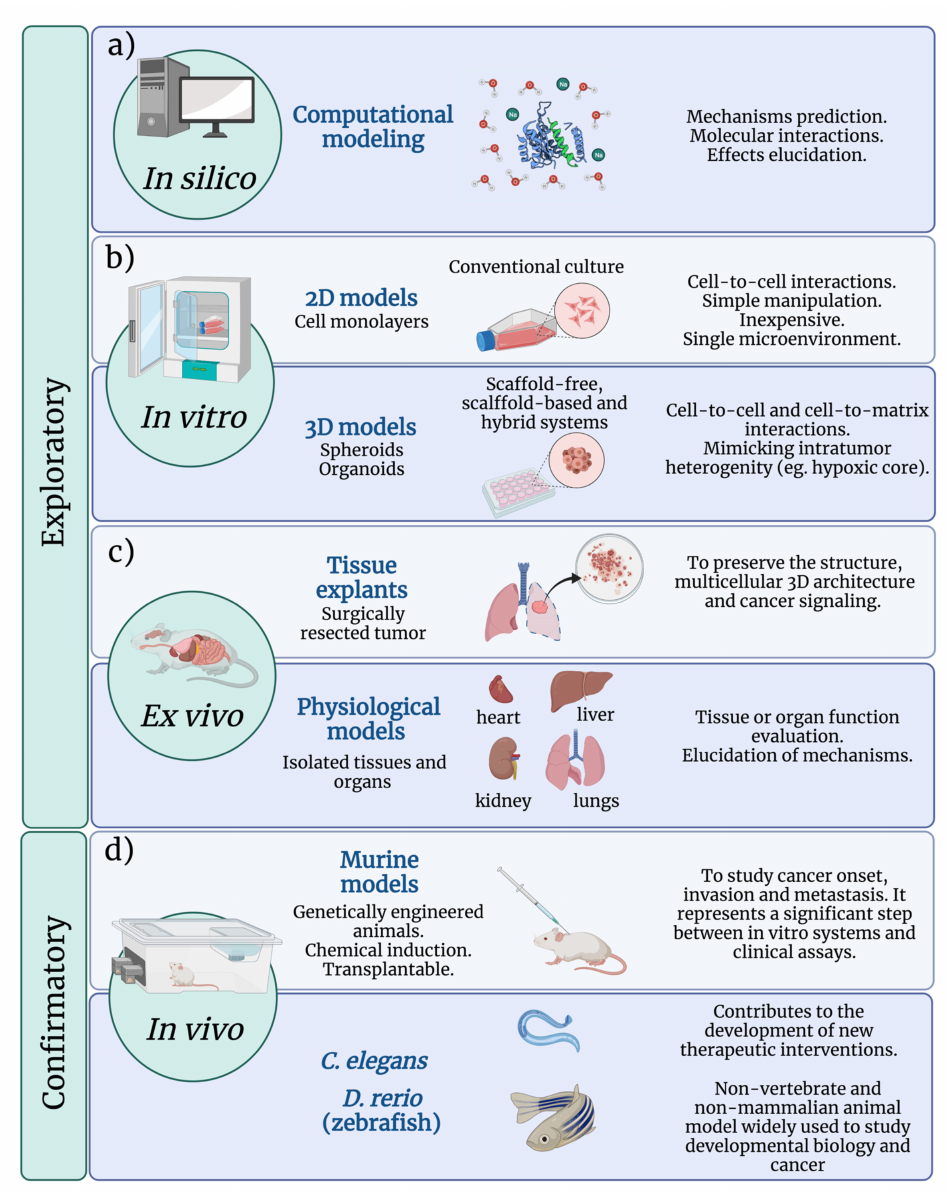
Figure 4. Features of ( a ) in silico ( b ) in vitro, ( c ) ex vivo, and ( d ) in vivo MNP evaluation